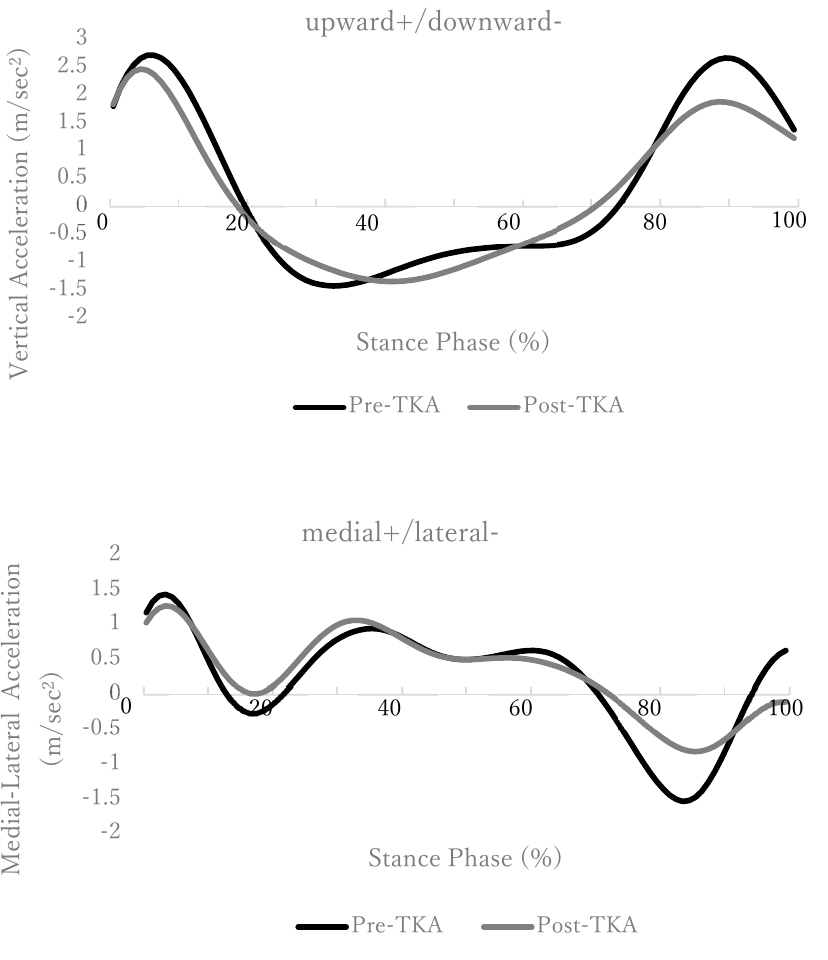
Figure 1. Time-series changes in acceleration during the stance phase of walking. The upper figure shows the vertical acceleration data, and the lower figure is the lateral acceleration data. The black line indicates pre − TKA, and the gray line indicates post − TKA. Table 4. Changes in lateral acceleration during the walking stance